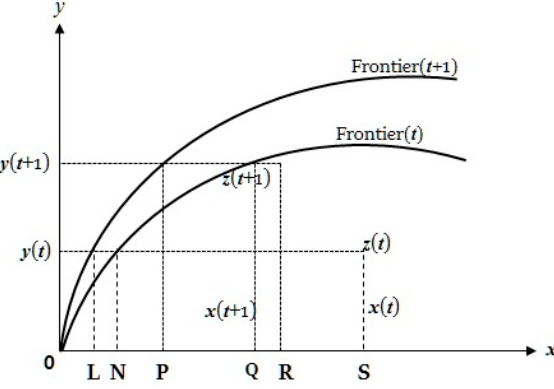
Figure 1. Malmquist Productivity Growth Index. (Source: [54]).